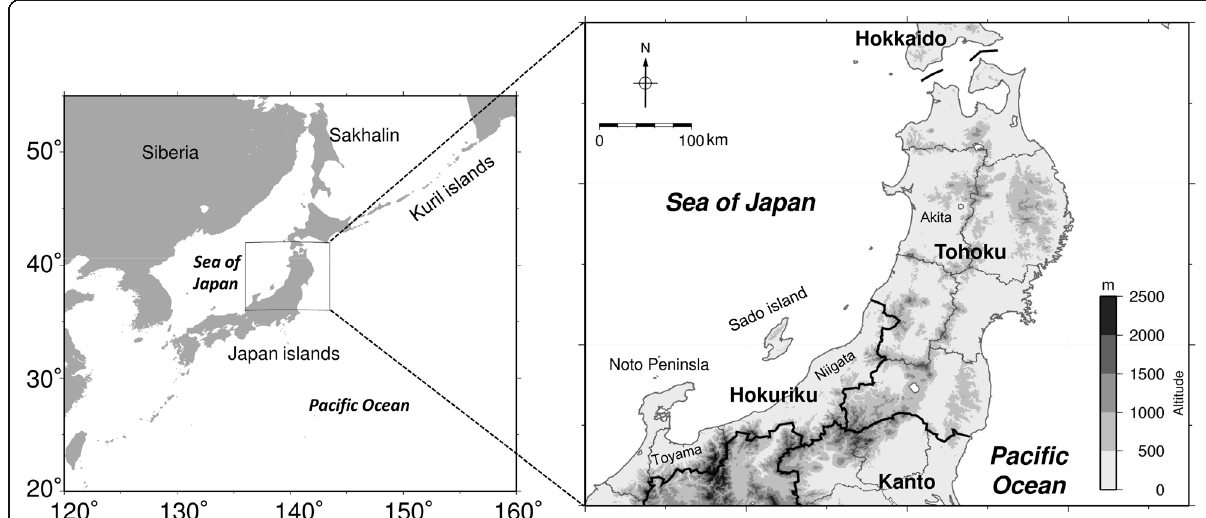
Fig. 1 Maps of the coastal areas of the Sea of